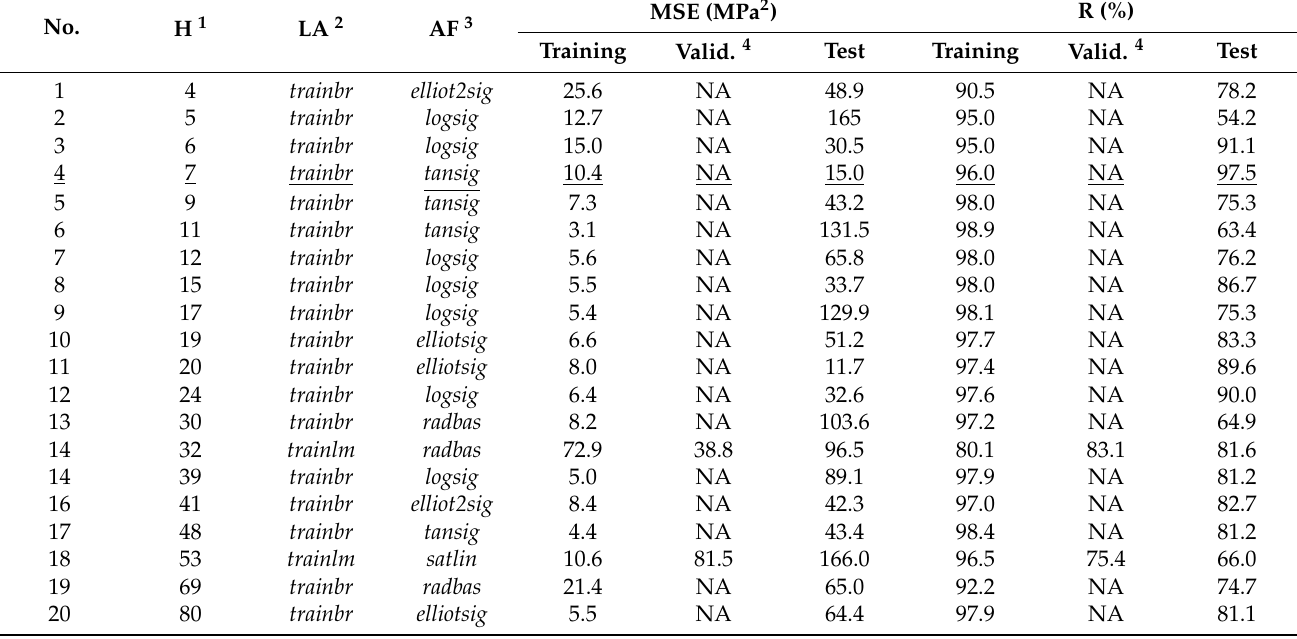
Figure 5. Optimisation of the number of neurons in the hidden layer based on cross-validation. Table 2. Selecting the optimal model based on the Matlab code results.